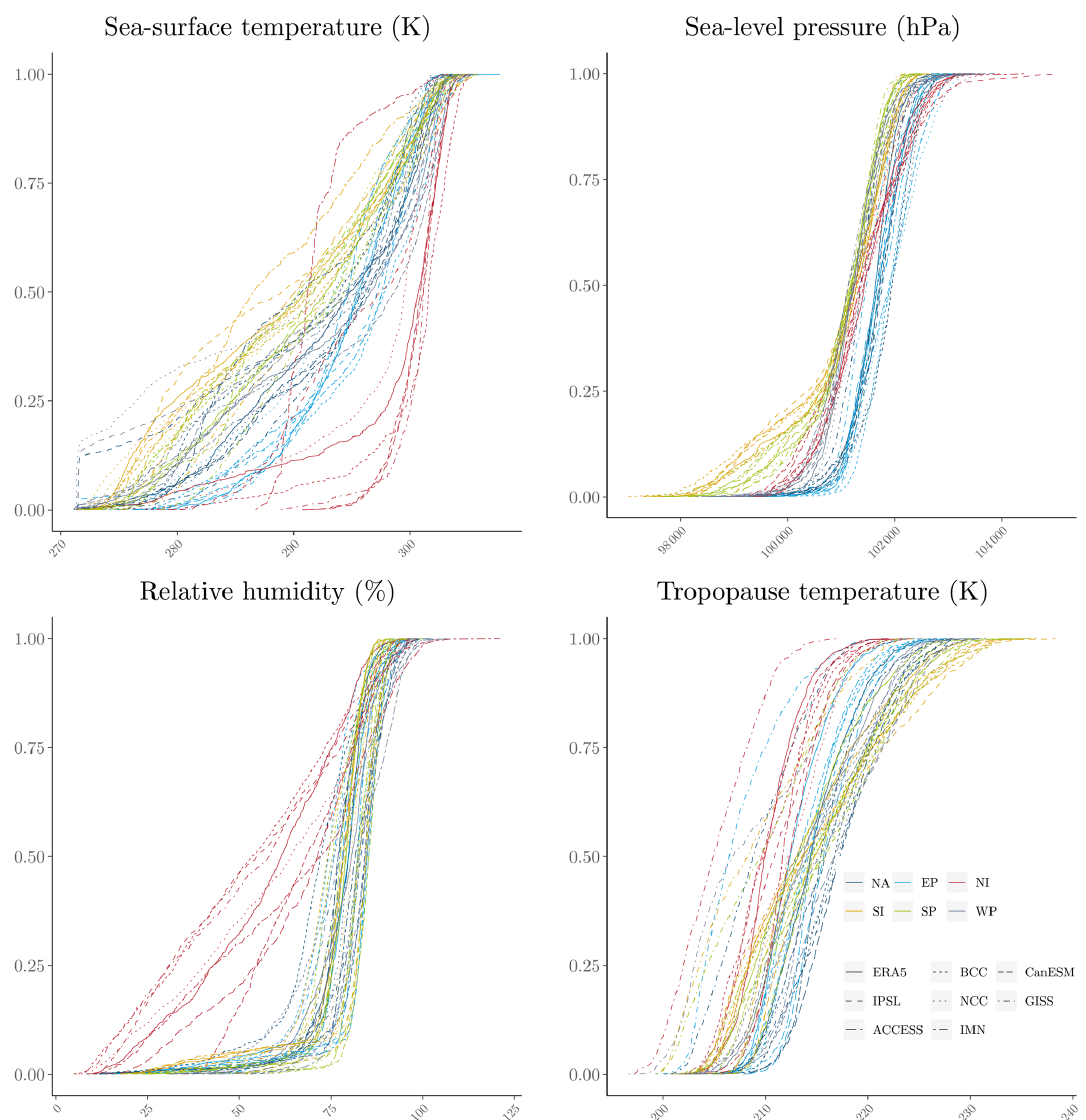
Figure A7. Cumulative distribution functions per basin for the variables of interest along synthetic tracks produced with ERA5 and extracted (at the same location) from climate data produced by the seven climate models. NA: North America, EP: eastern Pacific, NI: northern India, SI: southern India, SP: South Pacific, WP: western Pacific. The bias-correction module is indeed fitted on a larger range of climate conditions. By definition, for the genesis of the cyclones, the time of year and the location are in line with historical cyclone data. However, in the bias- correction module, the synthetic tracks are generated without climate constraints; i.e., cyclones are allowed to drift relatively far away from their genesis location (in the limits of their initial basin) and therefore can cover conditions which do not lead to the formation of tropical cyclones. At this stage, these tracks are not to be considered “TC tracks” but “candidate” tracks. In the following stage, TC tracks will be generated from candidate tracks by filtering those ones where meteorological conditions for cyclone formation are